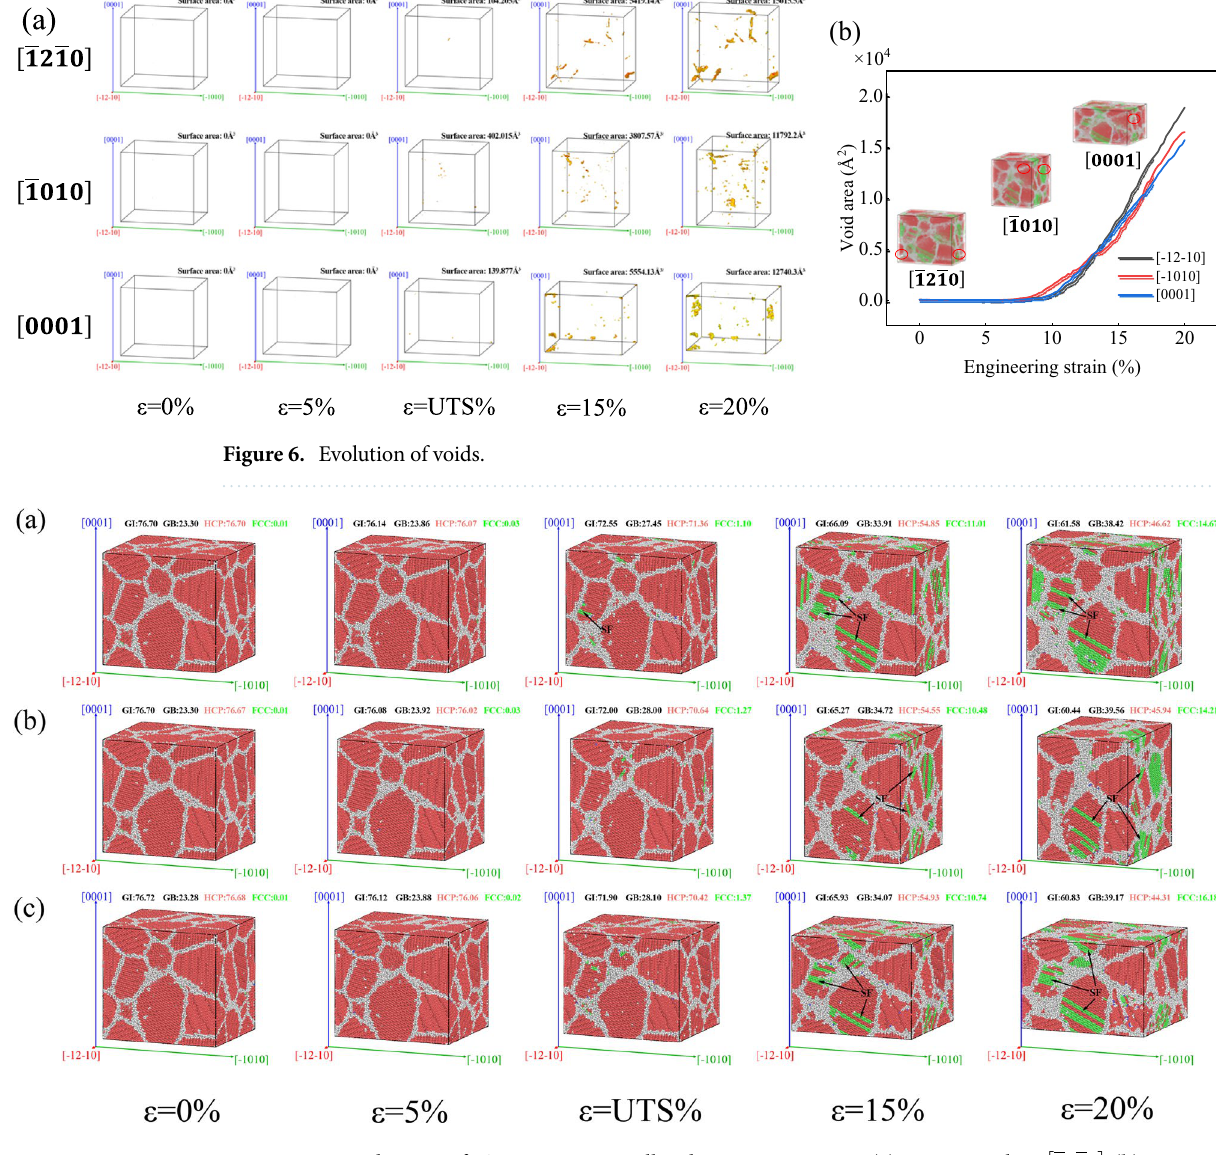
Figure 7. CNA diagram of AZ31 magnesium alloy during compression. ( a ) Compress along compress